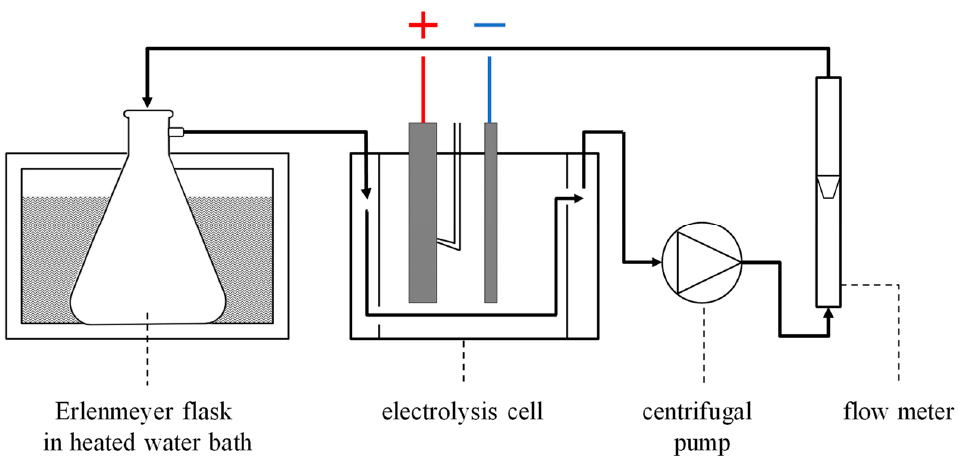
Figure 2. Experimental setup.